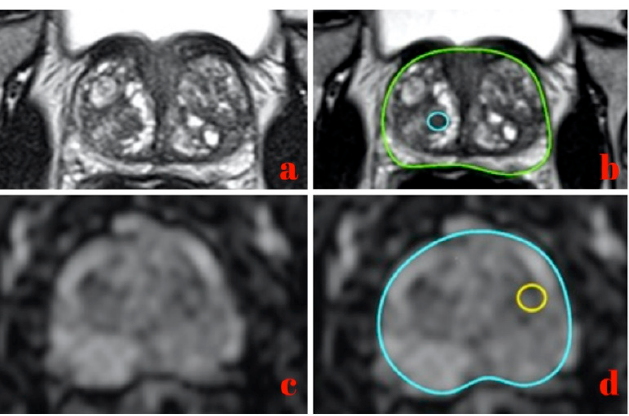
Figure 1. Image segmentation on a T2w MRI slice ( a , b ) and ADC MRI slice ( c , d